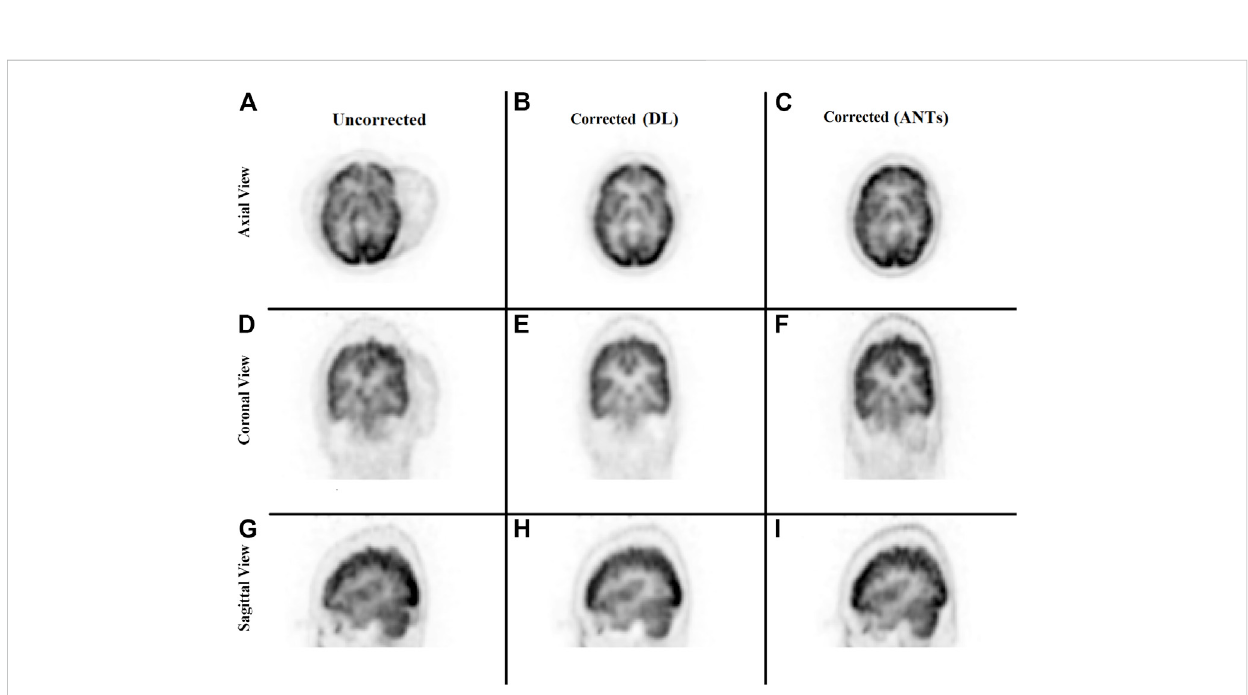
FIGURE 6 Qualitative comparisonoftheneuralnetworkperformanceinmotion correctionbymeansofframe-by-frameimageregistration.Rowsfromtopto bottom show the sum of the three frames without any correction (A, D, G) , correction using the deep learning approach (B, E, H) , and the ANTs iterative algorithm (C, F, I) , respectively, in the axial, coronal, and sagittal